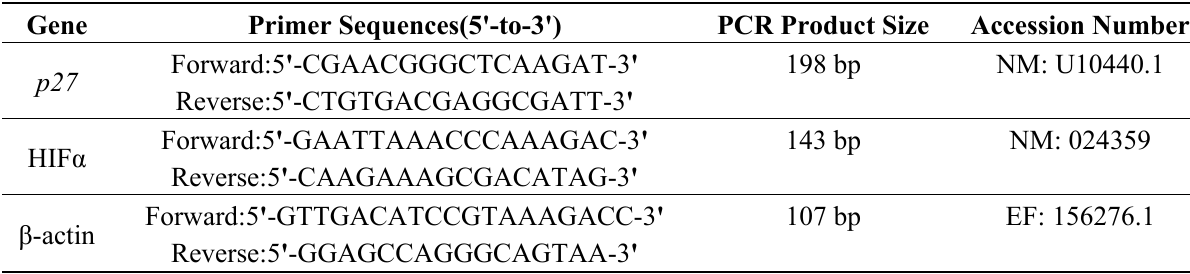
Table 1. Primer sequences used in real-time